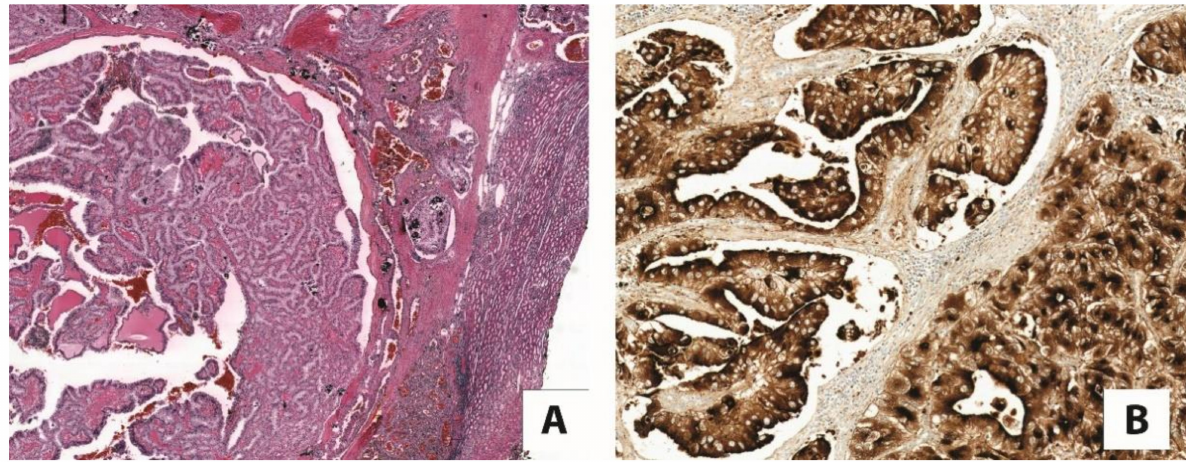
Figure 1. An example of ( A ) TFE3-rearranged renal cell carcinoma with papillary architecture (5 × ), ( B ) strongly and diffusely positive for cathepsin K (20 ×